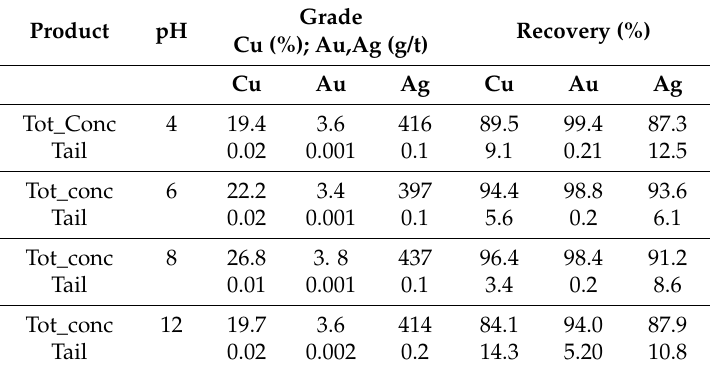
Table 3. Grade and Recovery results with respect to varying pH at collector concentration 4 × 10 − 5